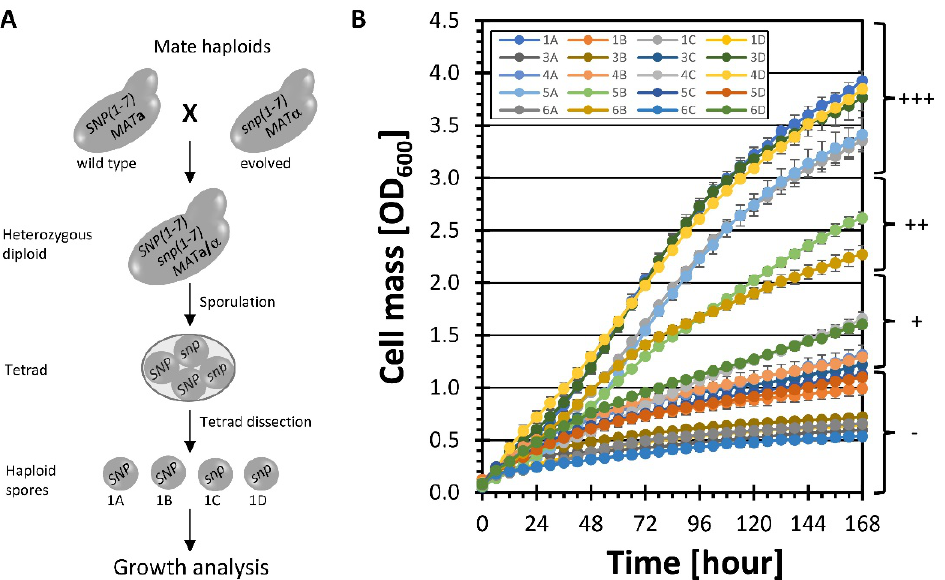
Figure 3. Identification of mutations present in strains with improved growth on xylose. ( A ) Sporulation of the heterozygous diploid strain YRH1981 was performed to re-distribute SNPs among haploid spores. ( B ) Each haploid spore was grown on YP medium + 50 g/L xylose to identify strains that maintained the ability to grow well on xylose. Plots are the average values from at least three biological replicates. Error bars show standard deviations. For lower OD values, error bars are smaller than the symbol. Growth ratings ( − , +, ++, +++) are used in Table 4. Table 4. Tetrad analysis.